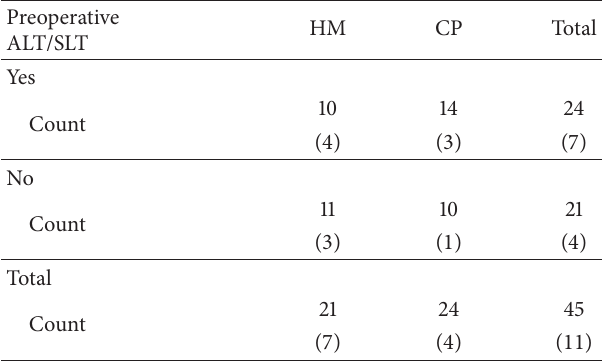
Table 3: Distribution of eyes between the treatment groups accord- ing to a previous treatment (yes) by argon laser trabeculoplasty/ selective laser trabeculoplasty (AST/SLT). Within brackets, the number eyes showing a complete clinical success (i.e., no medica- tions) at the end of the